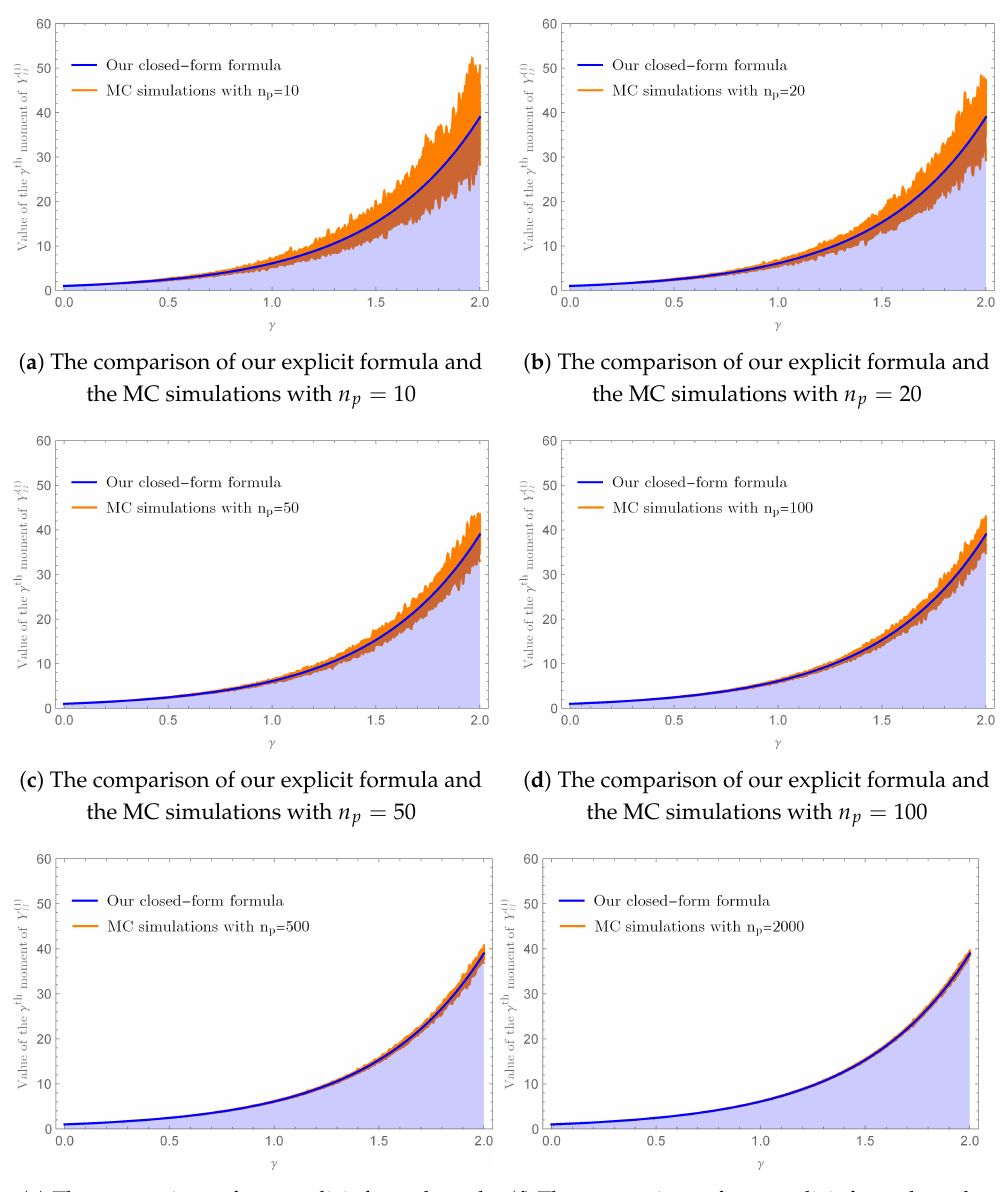
(cid:104) (cid:105) ( Y ( 1 ) ) γ obtained from MC simulations 11